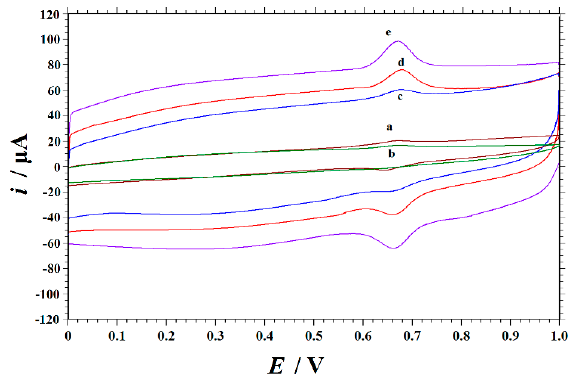
Figure 4. Cyclic voltammograms of 10.0 µ M rutin on the different electrodes in 0.2 M H 2 SO 4 : GCE ( a ), GO/GCE ( b ), NH 2 -Fe 3 O 4 NPs-GO/GCE ( c ), ErGO/GCE ( d ), and NH 2 -Fe 3 O 4 NPs-ErGO/GCE ( e ). The scan rate of 0.1 V/s.